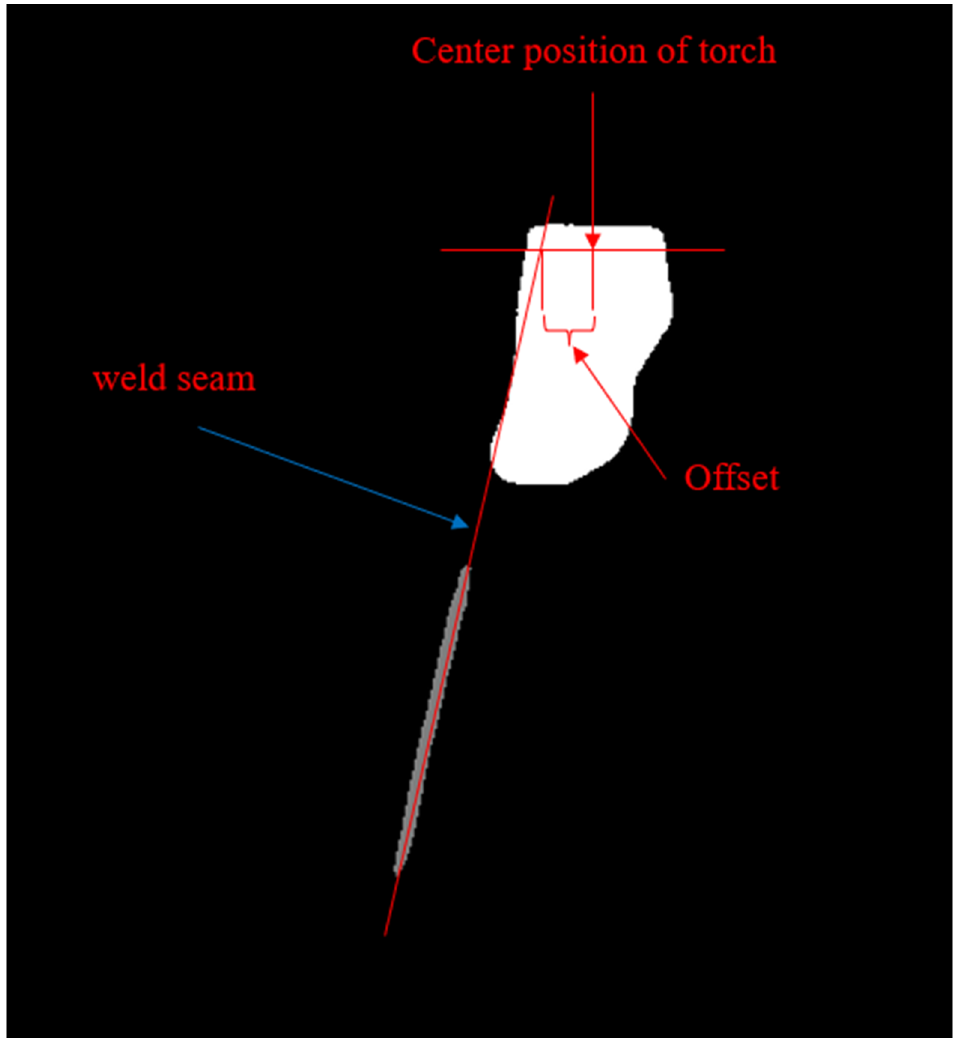
Figure 7. Schematic diagram of the offset calculation.